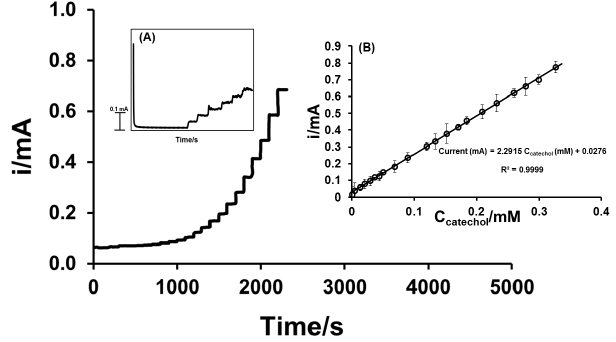
Figure 6. Amperometric responses of the PEDOT:PSS/20%IL/SPCE sensor in stirred PBS (pH 7.4) solution at an applied potential of 0.5 V to varying concentrations of catechol from 0.1 µM to 330.0 µM; insert ( A ) zoom at the first seven standard additions of catechol and ( B ) plot of steady state current vs. catechol concentration.